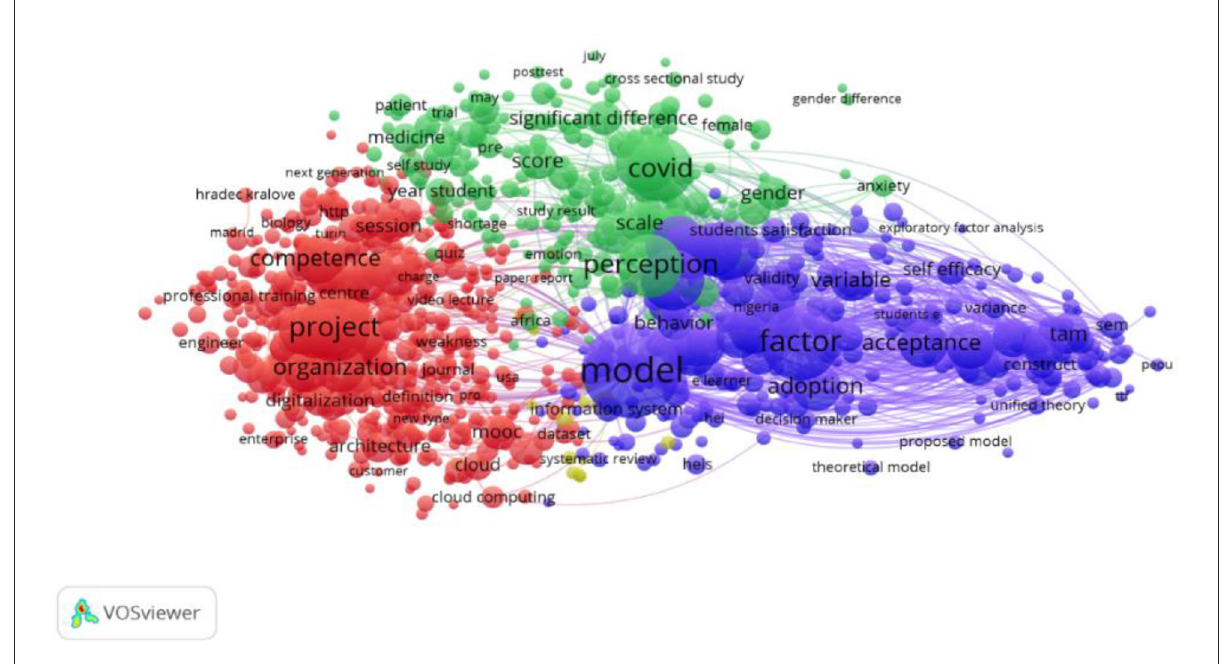
FIGURE1 Academic e-learning